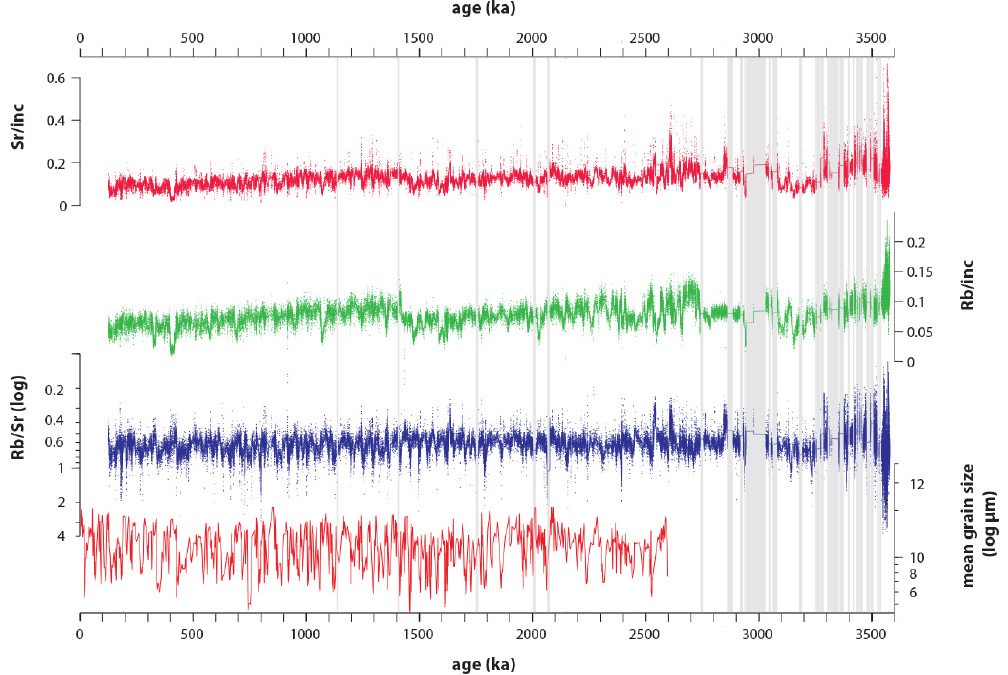
Figure 6. Mean grain size (from Francke et al., 2013), incoherent scatter normalized Rb (Rb/inc) and Sr intensities (Sr/inc), and Rb/Sr ratios derived by XRF scanning in the sediment record from Lake El’gygytgyn vs. age. XRF data are plotted as raw data (dots) and 101-point (Sr; Rb/Sr) or 201-point weighted running average (colored lines). Gaps in the record are shaded with grey bars. Please not the reverse scaling of the Rb/Sr ratio